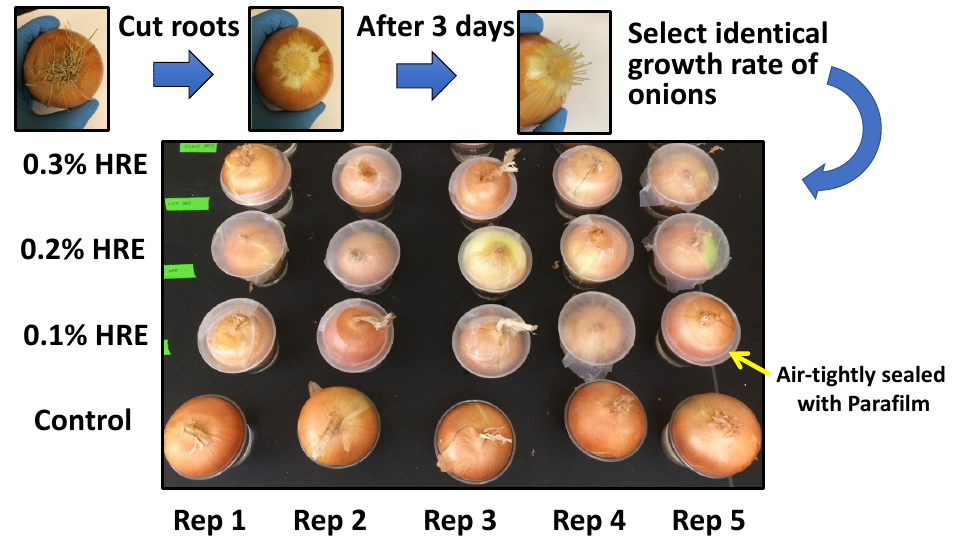
Figure 8. Onion root growth rate (per day) measurement using various concentrations of horseradish extract (0%, 0.1%, 0.2%, and 0.3% aqueous extract). Identical growth rate of onion roots was selected and used for this allelopathic assay after cutting onion roots and regrowth 3 days.